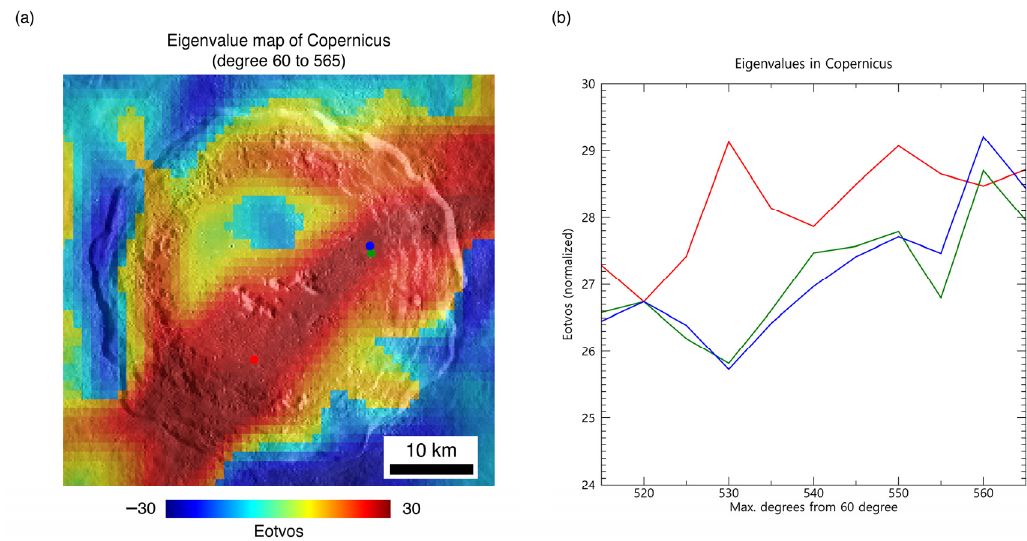
Figure 5. Eigenvalues map and eigenvalue variation of the Copernicus pits region. ( a ) In the positive feature corresponding to the wall of the buried crater, a mass deficit appeared in only three points, and the two points (green and blue) are adjacent to each other. ( b ) Green and blue points adjacent to each other show similar eigenvalue variation. The graph is normalized at 520 degrees to make it easier to see the trend change.